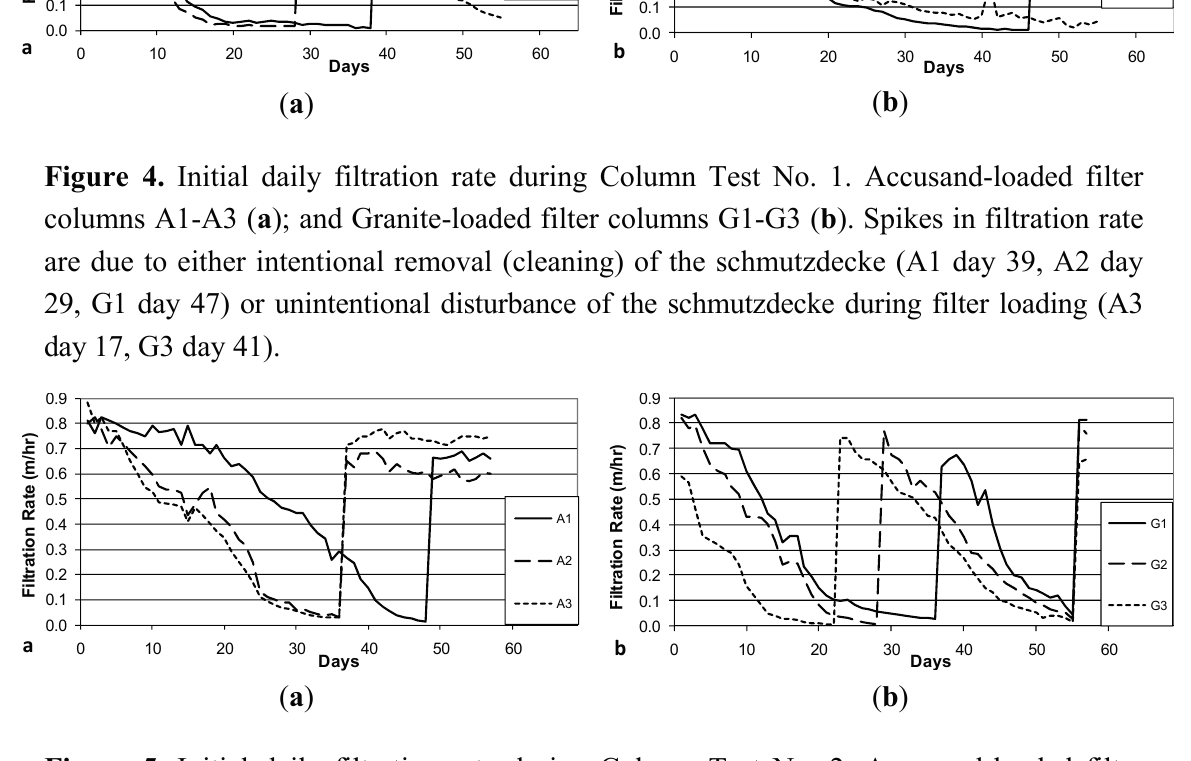
Figure 5. Initial daily filtration rate during Column Test No. 2. Accusand-loaded filter columns A1-A3 ( a ); and Granite-loaded filter columns G1-G3 ( b ). Spikes in filtration rate are due to intentional removal (cleaning) of the schmutzdecke (A1 day 49; A2 day 37; A3 day 37; G1 days 37 and 56; G2 days 29 and 56; G3 days 23 and